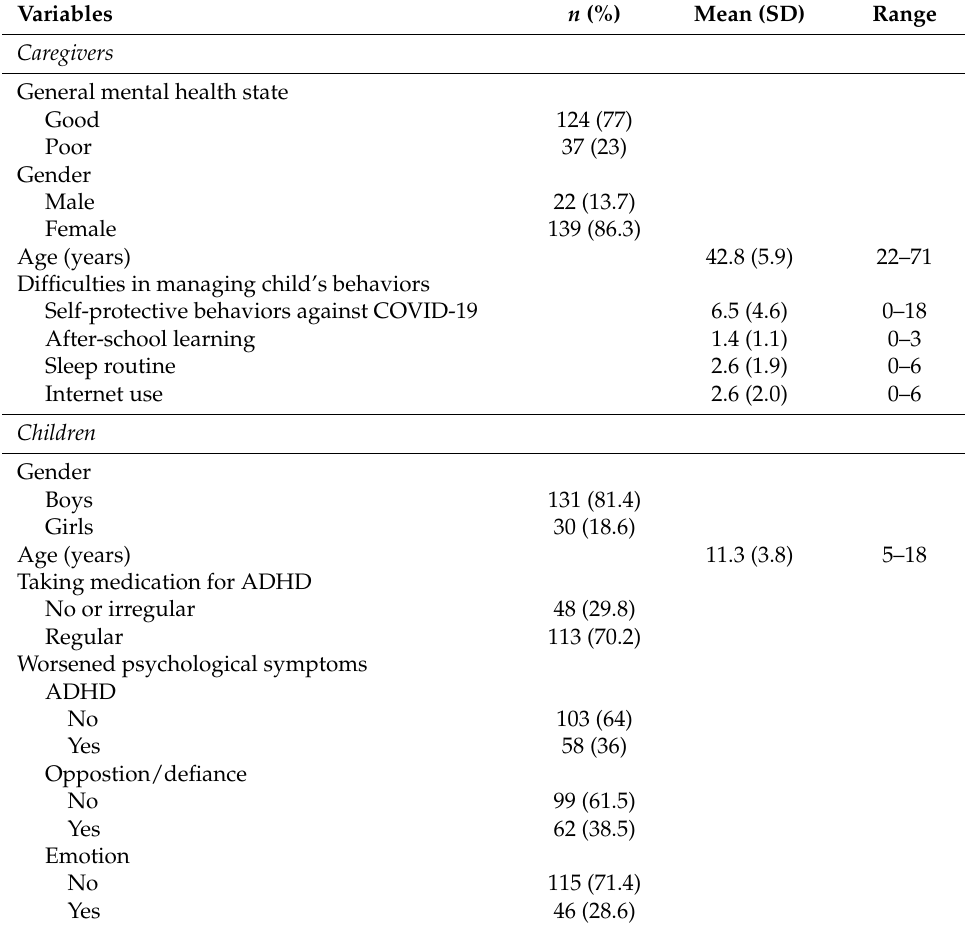
Table 2. Demographics, caregiver mental health, and Difficulties in Managing Child’s Behaviors, and Children’s Treatment and Worsened Psychological Symptoms ( n =